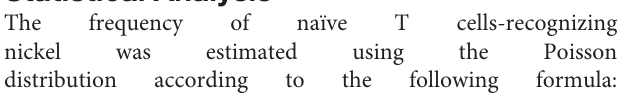
frequencies above 0.5% of the total repertoire were considered to be Highly Expanded Clones